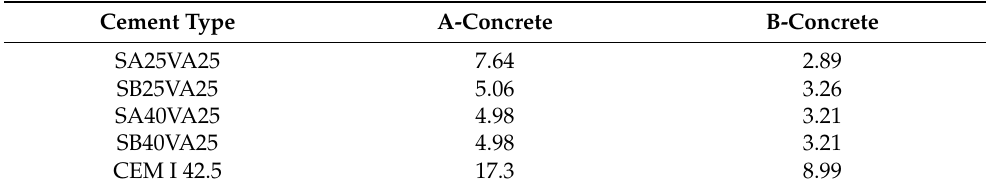
Table 5. Chloride diffusion coefficient (D eff × 10 − 12 m 2 /s) determined after 90 days of testing time.